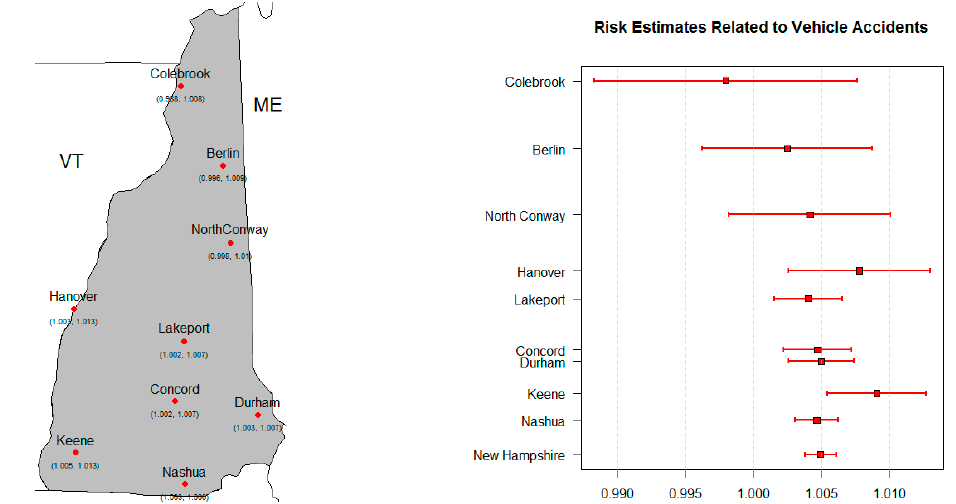
Figure 3. Risk estimates for hospital visits related to vehicle accidents associated with a 1°C increase in temperature, reported with a 95% CI.